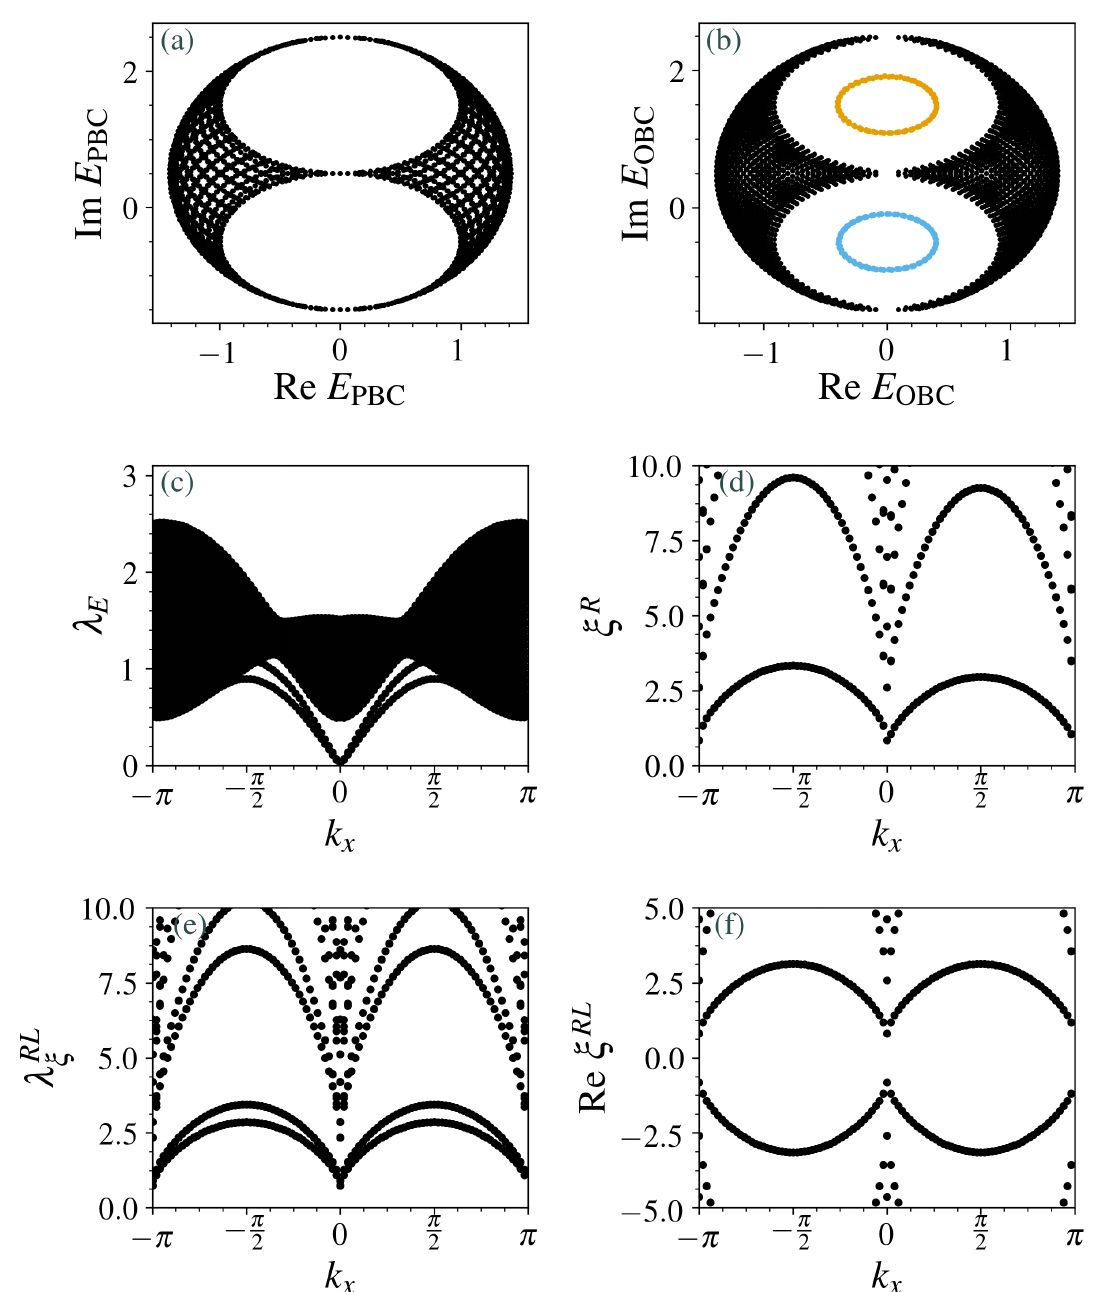
Figure 10: We fix µ = 0.5 and δ = 0.1. (a) Energy spectrum of the model in Eq. (48) for periodic boundary conditions. (b) Energy spectrum on a cylinder geometry. The = 0 for highlighted bands are not edge states but two fixed momentum bands ( k x = π for the positive imaginary parts). The the negative imaginary parts and k x discontinuity in the band structure is due to the instability of the eigenvalues in non- Hermitian systems [ 57 ] . (c) Singular value spectrum of the OBC model. Two degen- erate zero singular modes appear and are topologically protected. (d) Entanglement spectrum of the right density matrix. (e) Singular values of the biorthogonal entan- glement Hamiltonian. (f) Real part of the biorthogonal entanglement Hamiltonian. In (d-f), we observe low energy gapped edge modes which are caused by the pres- ence of two set of Dirac cones with opposite chirality, but no stable zero modes as in the singular value decomposition of the Hamiltonian